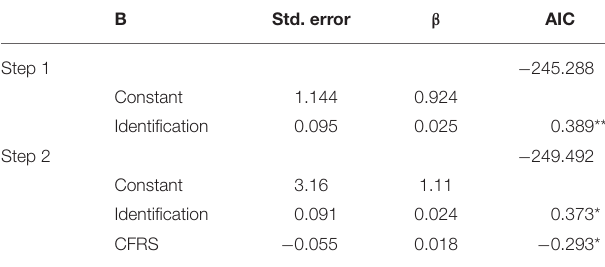
TABLE 2 | Regression model predicting thematic